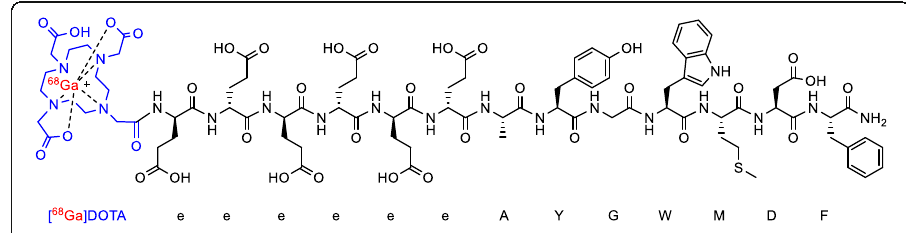
Fig. 3 Chemical structure of [ 68